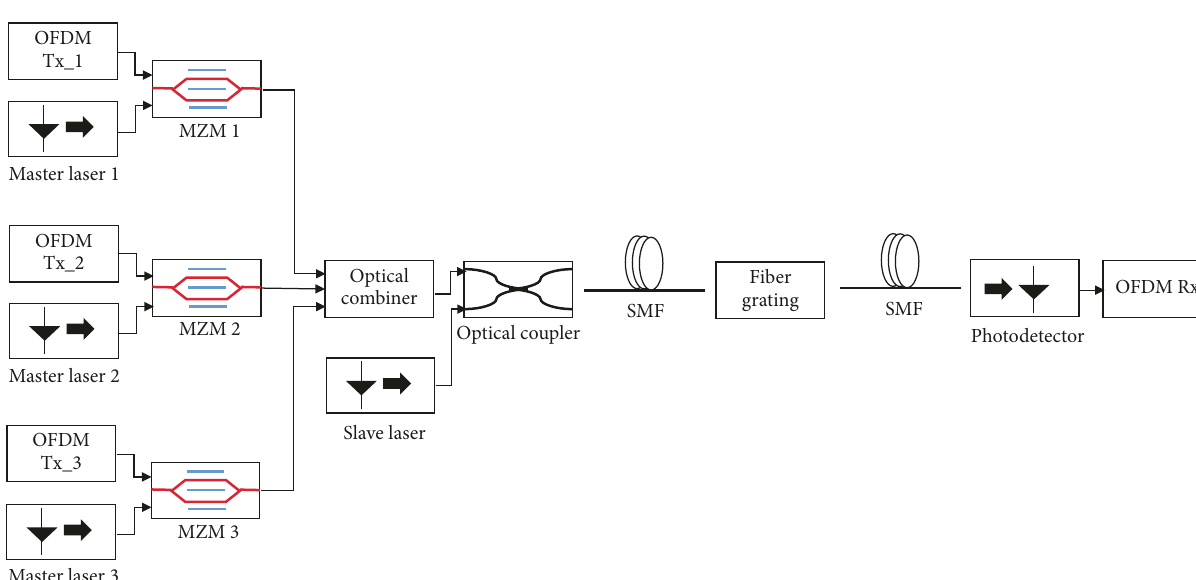
shift or bias point. The power transfer characteristics of MZM are good at quadrature bias point for direct-detection systems